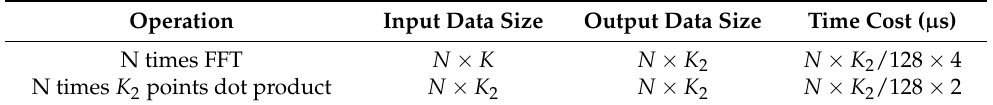
Table 2. The major time cost of our